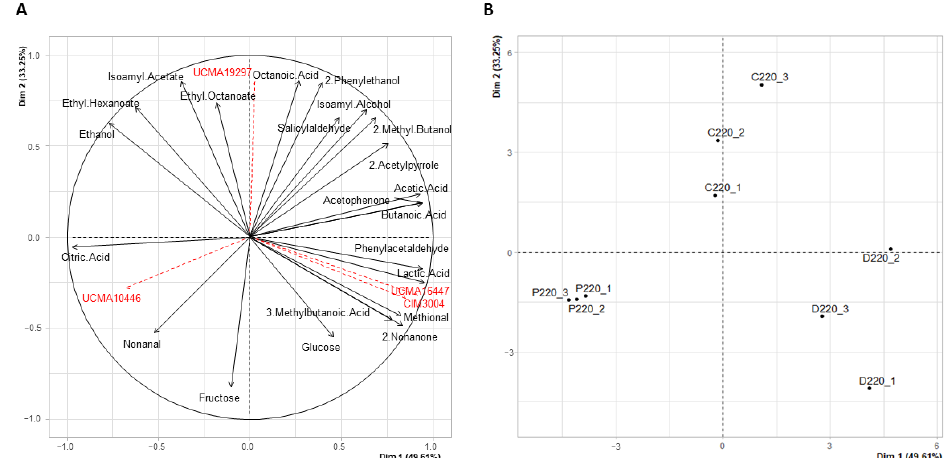
Figure 5. ( A ) Principal Component Analysis of the studied compounds (black arrows) with illustrative variables representing the four strains of the model (red arrows). ( B ) Distribution of the samples in condition C (control), D (disturbance without phages) and P (disturbance with phages) at 220 h for the experiment at 15 °C. Samples are named as follows: Condition (C: control, D: disturbance without phages, P: disturbance with phages). Time point, 220 h. Biological replicate (1, 2, 3) (e.g., C220_1 means Control at 220 h, biological replicate 1).